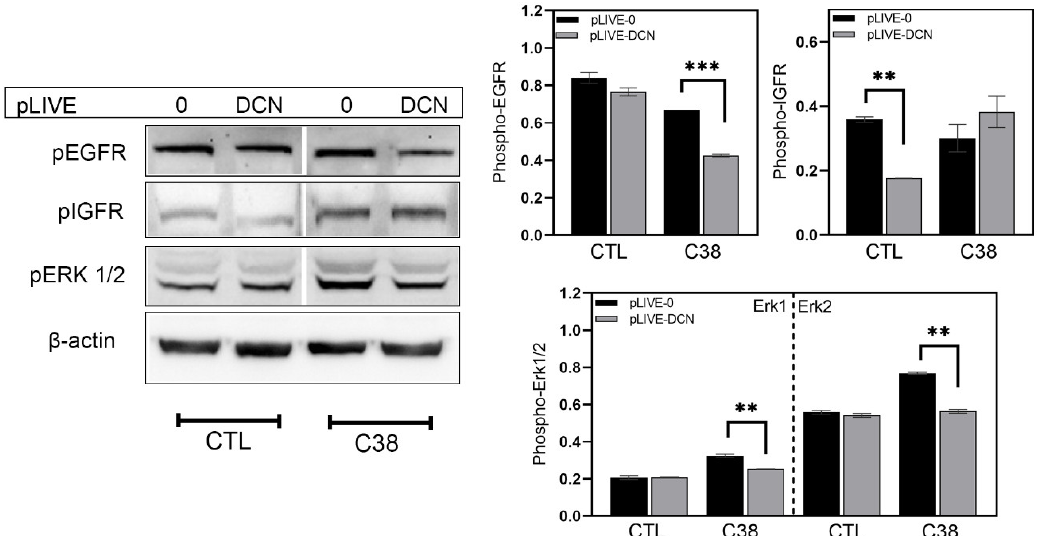
Figure 6. Western blot analysis of different signal transduction pathways. Bar charts illustrate the relative level of different proteins in wild type and c38-injected groups. β-actin was used as a housekeeping protein. All data are indicated as mean ± SD. ** p value < 0.01; *** p value < 0.001.